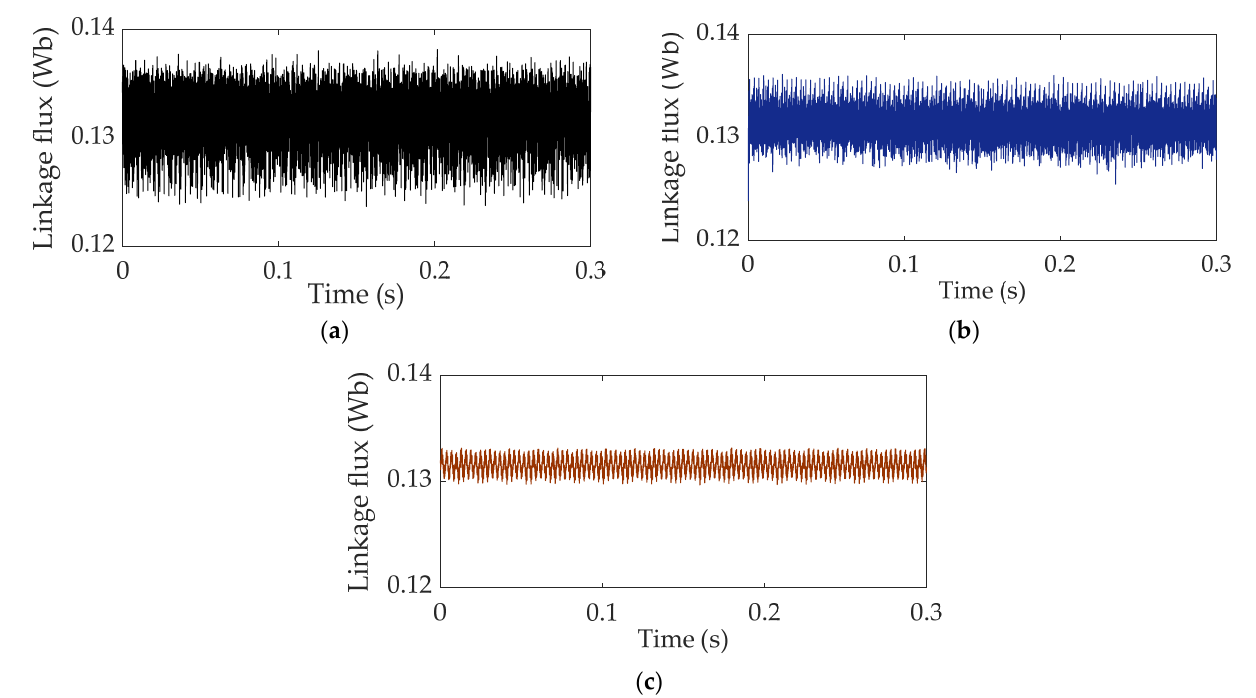
Figure 10. Flux linkage at a steady-state speed of 1500 r·min − 1 with a 10 N·m load for the ( a ) TDTC, ( b ) CMPTC, and ( c ) proposed MPTC methods.